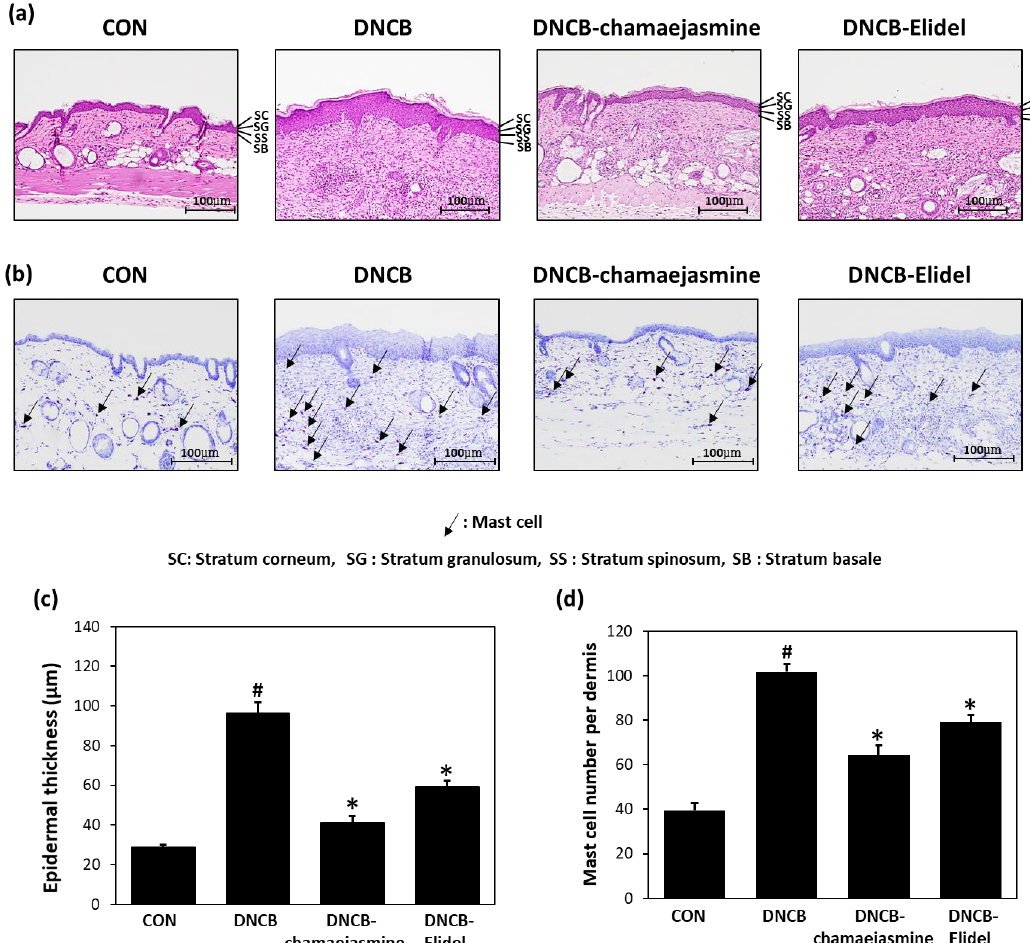
Figure 4. Effects of chamaejasmine on the development of DNCB-induced AD-like skin lesions in SKH-1 hairless mice. ( A ) Schematic representation of the experiment and ( B ) clinical features of DNCB-induced AD-like skin symptoms. CON: vehicle control group, DNCB: DNCB-treated control group, DNCB-chamaejasmine: DNCB and 0.5% chamaejasmine-treated group, DNCB-Elidel: DNCB and 1% pimecrolimus cream-treated group.